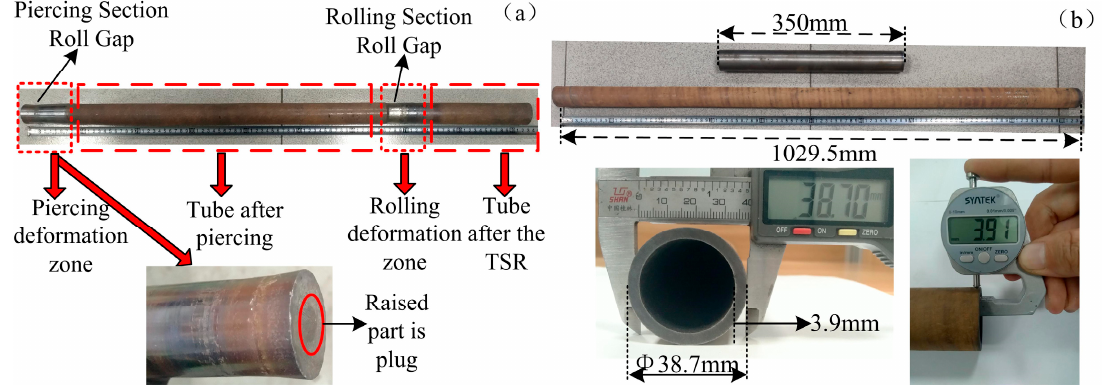
Figure 11. Seamless tube appearance: ( a ) artificial shutdown; ( b ) tube after the TSR